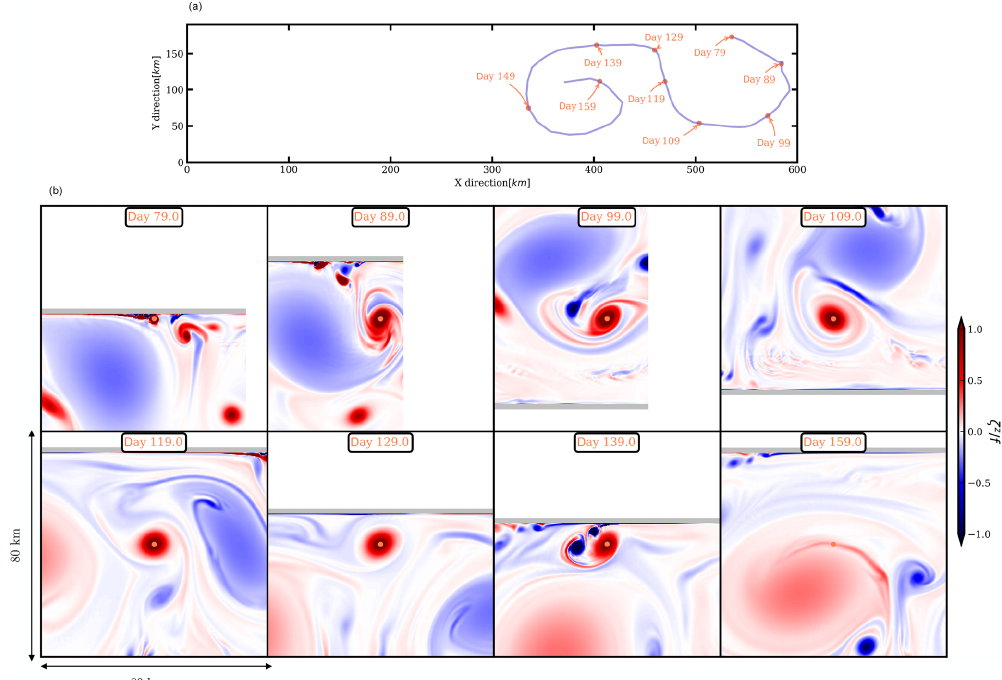
Figure 8. (a) Pathway of a submesoscale cyclone originating from the bottom boundary layer. (b) Major events from the birth to the death of the small vortex.